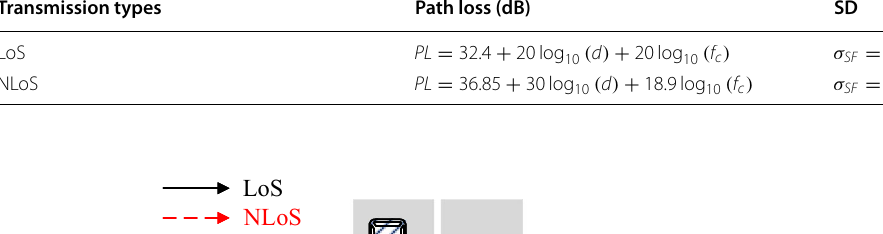
Table 1 Path loss channel models in different transmission types Transmission types